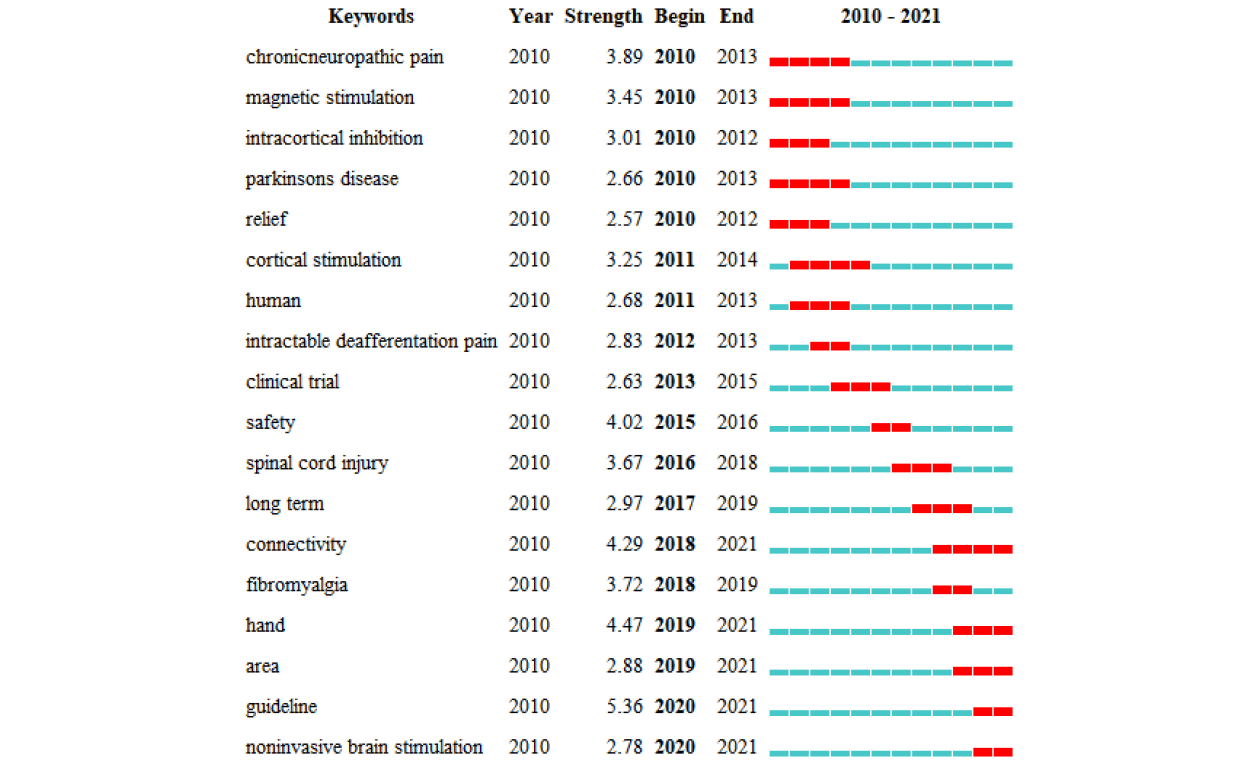
FIGURE 8 | Top 18 keywords with the strongest citation bursts of the 440 included studies from 2010 to 2021.